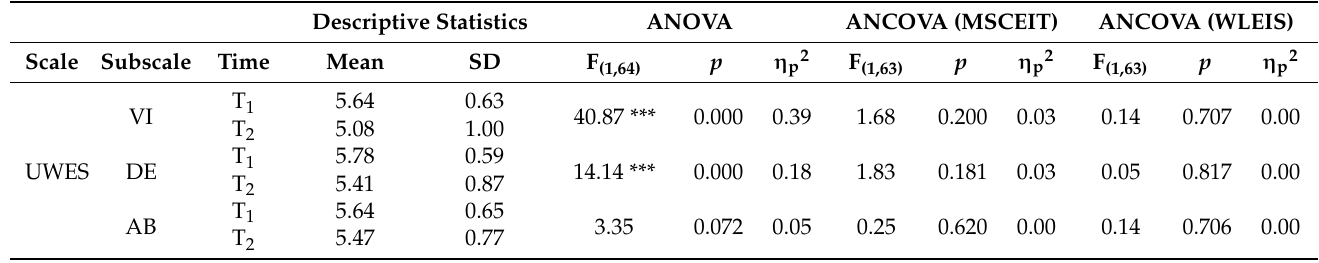
Table 3. Repeated measures ANOVA and ANCOVA results for work engagement.